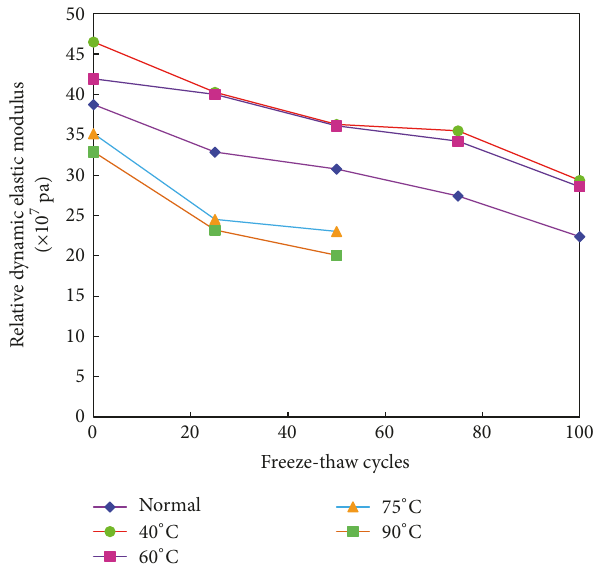
Figure 7: Relationship between the number of freeze-thaw cycles and the relative dynamic elastic modulus under different tempera-